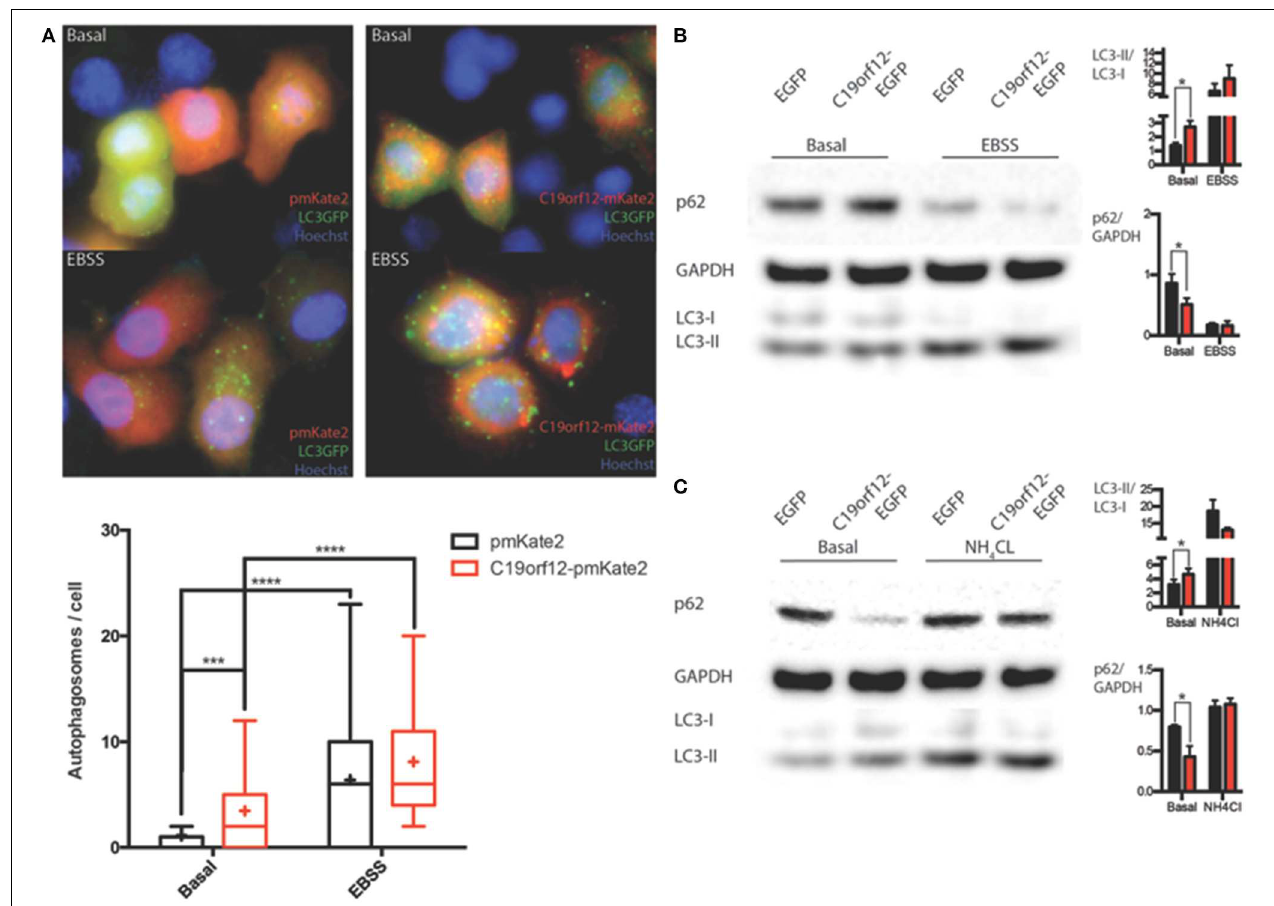
FIGURE 8 | Analysis of autophagy during C19orf12 wild-type overexpression. Representative images of HeLa cells overexpressing C19orf12-mKate2 or empty pmKate2 simultaneously with the autophagic marker LC3-EGFP (A) in basal condition or after exposure to EBSS. In the lower panel quantification of autophagosome counts is displayed (cross, average; line, median; box, 25 and 75 percentile; bars, max and min value, n = 8 , *** p > 0 . 005 , **** p > 0 . 001 ). (B) Representative western